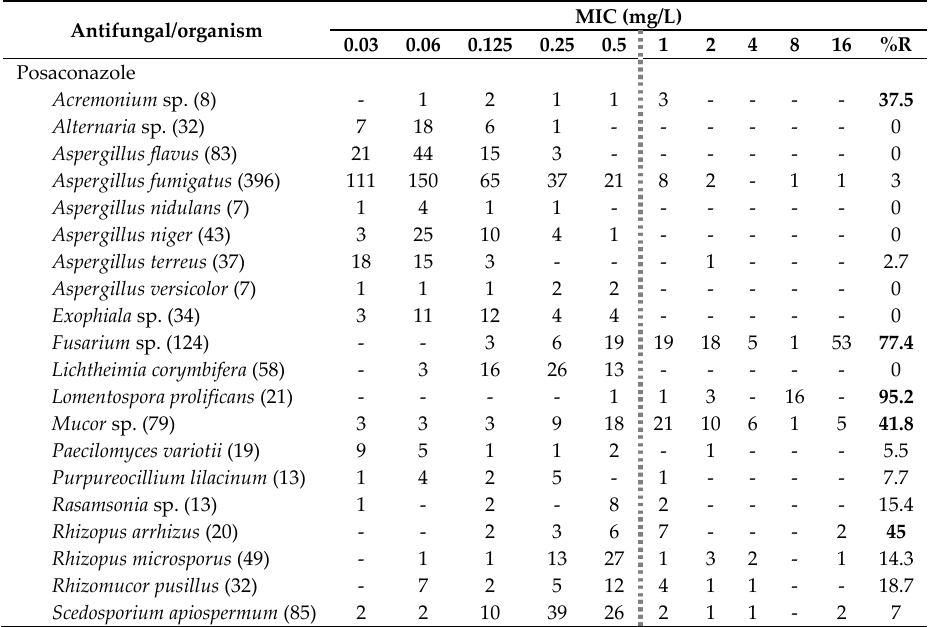
Table 3. MIC distributions for posaconazole. For presentation conventions, see Legend to Table 1. Antifungal/organism